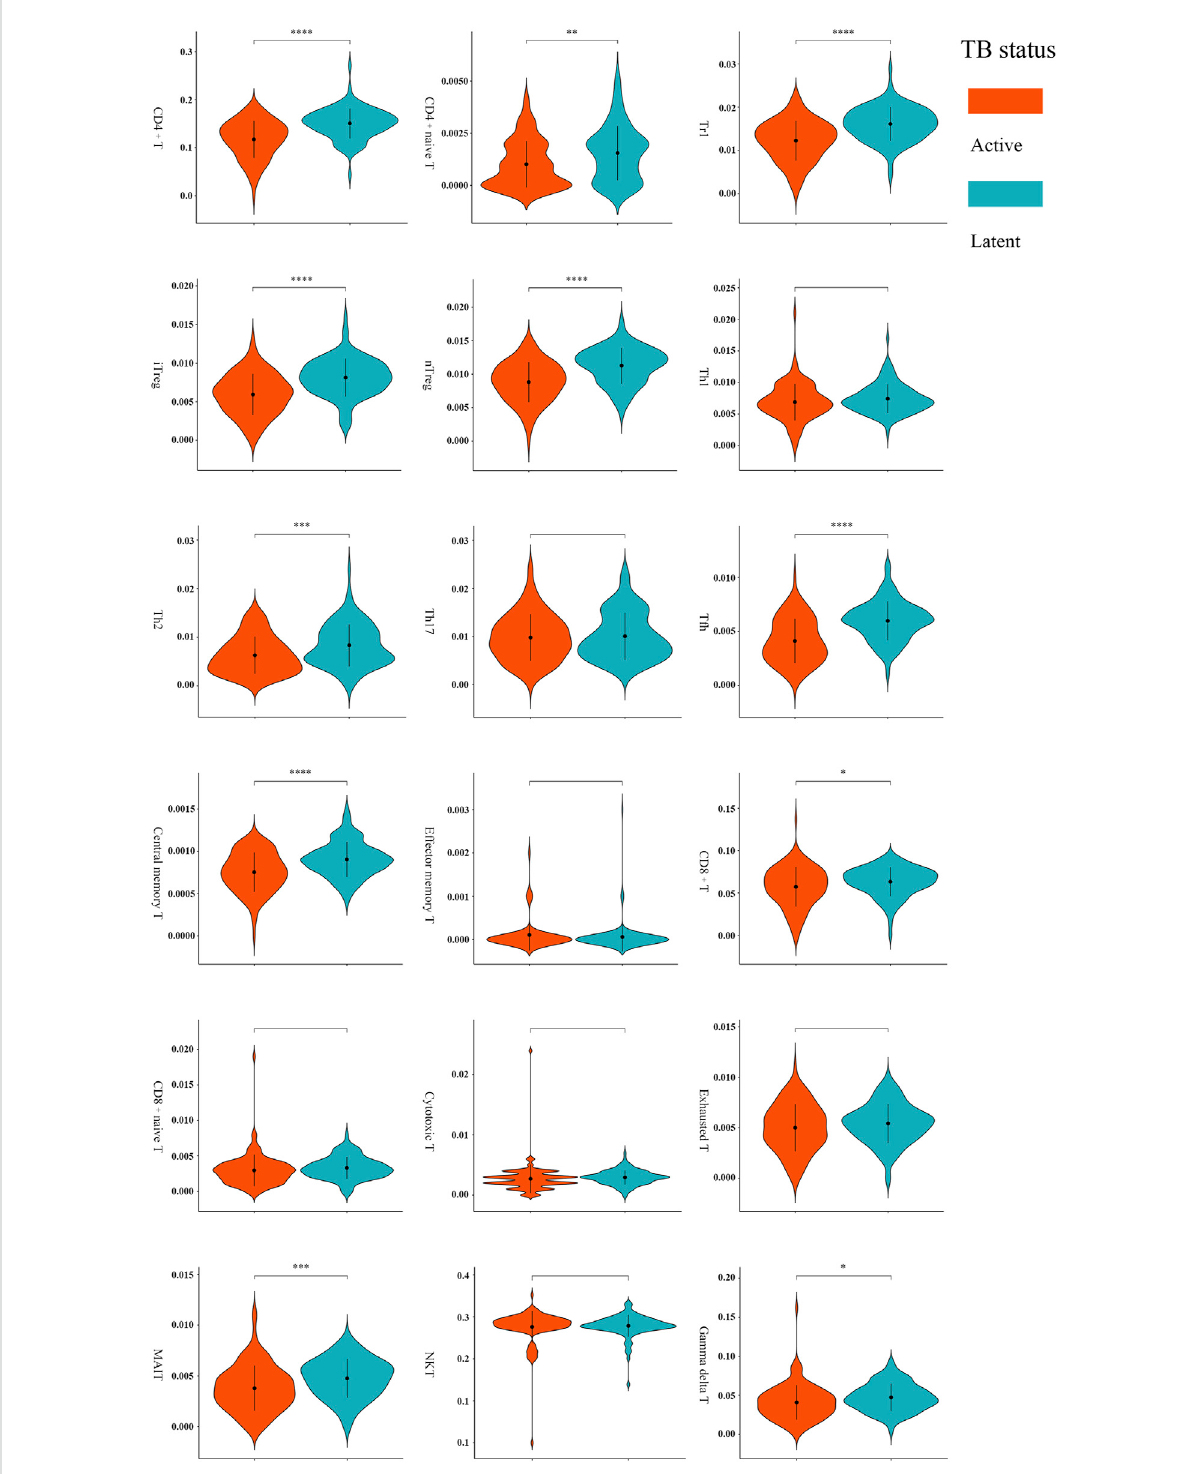
FIGURE 3 Comparisons of T-cell abundance between active and latent TB cases in the training set. * p < 0.05, ** p < 0.01, *** p < 0.001, and **** p < 0.0001 by